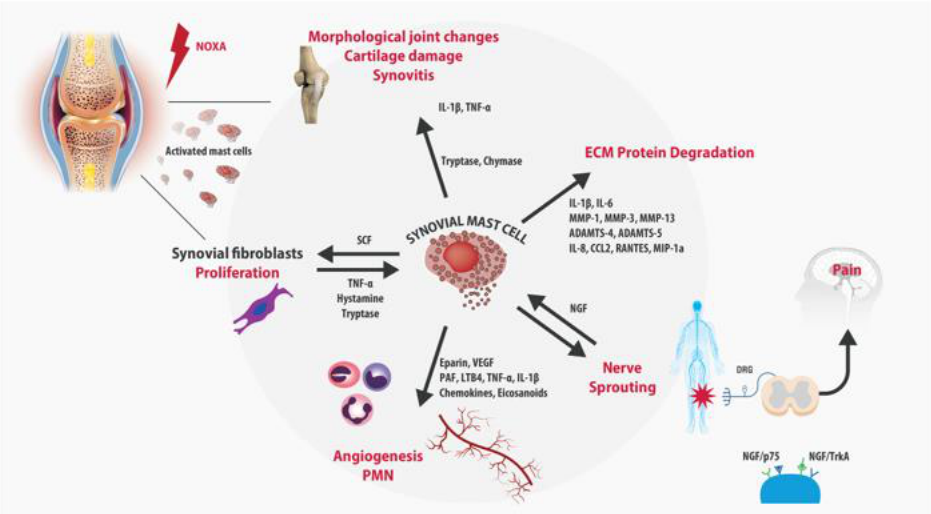
Figure 1. Schematic representation of the main contribution of MCs to degenerative joint diseases. Hyperactivated synovial MCs trigger the inflammatory process increasing vascular permeability and angiogenesis, recalling circulating PMN cells at the lesion site and activating synovial fibroblasts. Moreover, synovial MCs degranulation releases a massive amount of pro-inflammatory cytokines and chemokines, MMPs, and aggrecanases responsible for ECM protein degradation and, cartilage and bone remodeling.